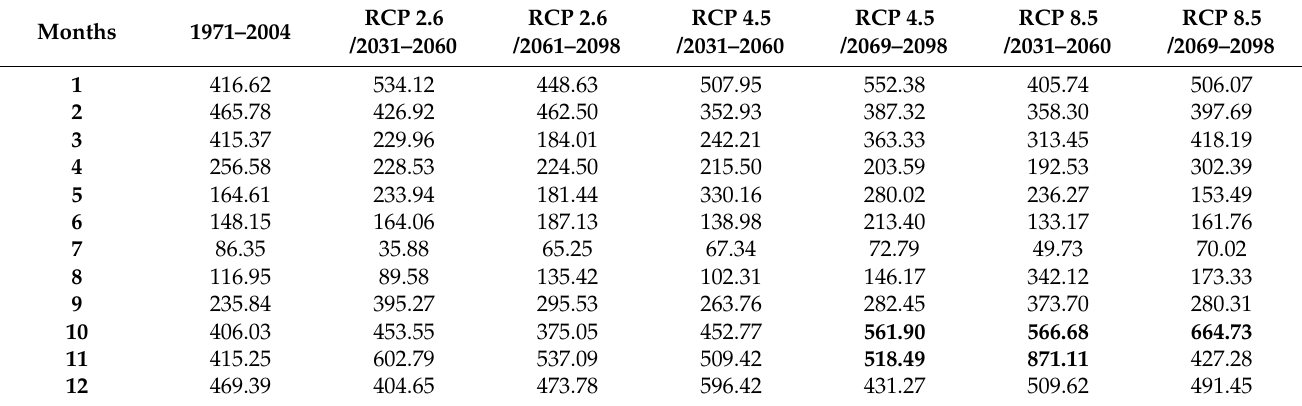
Table 4. Maximum monthly precipitation values for the reference period and climate